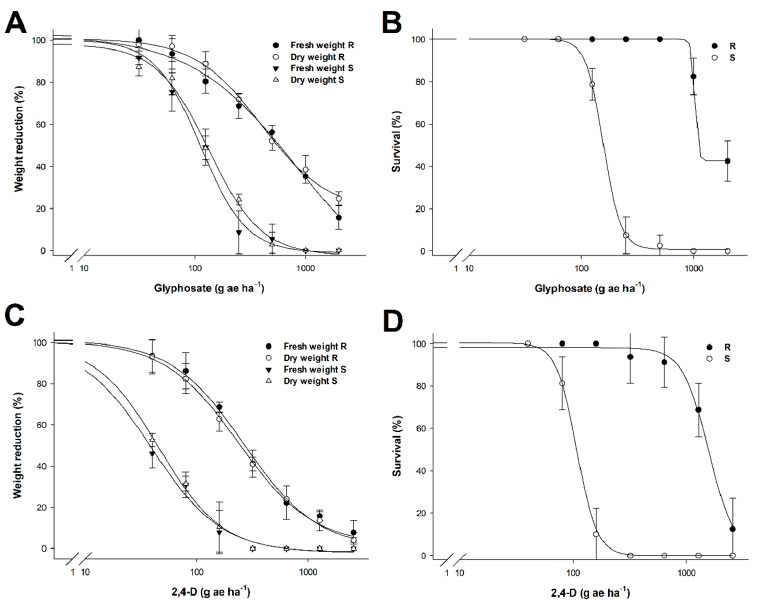
Figure 1. Dose–response curves in % reduction in fresh and dry weight ( A , C ) and % survival ( B , D ) treated with different doses of glyphosate and 2,4-D, respectively, expressed as a percentage of the mean of the untreated control of the R and S populations of C. acanthoides . Vertical bars represent the standard error of the mean ( n = 10). Table 2. Parameters of the log-logistic equation used to estimate the doses of glyphosate and 2,4-D (g ae ha − 1 ) required to decrease 50% of the fresh and dry / fresh weight (GR 50 ) or survival (LD 50 ) of the R and S populations of C. acanthoides